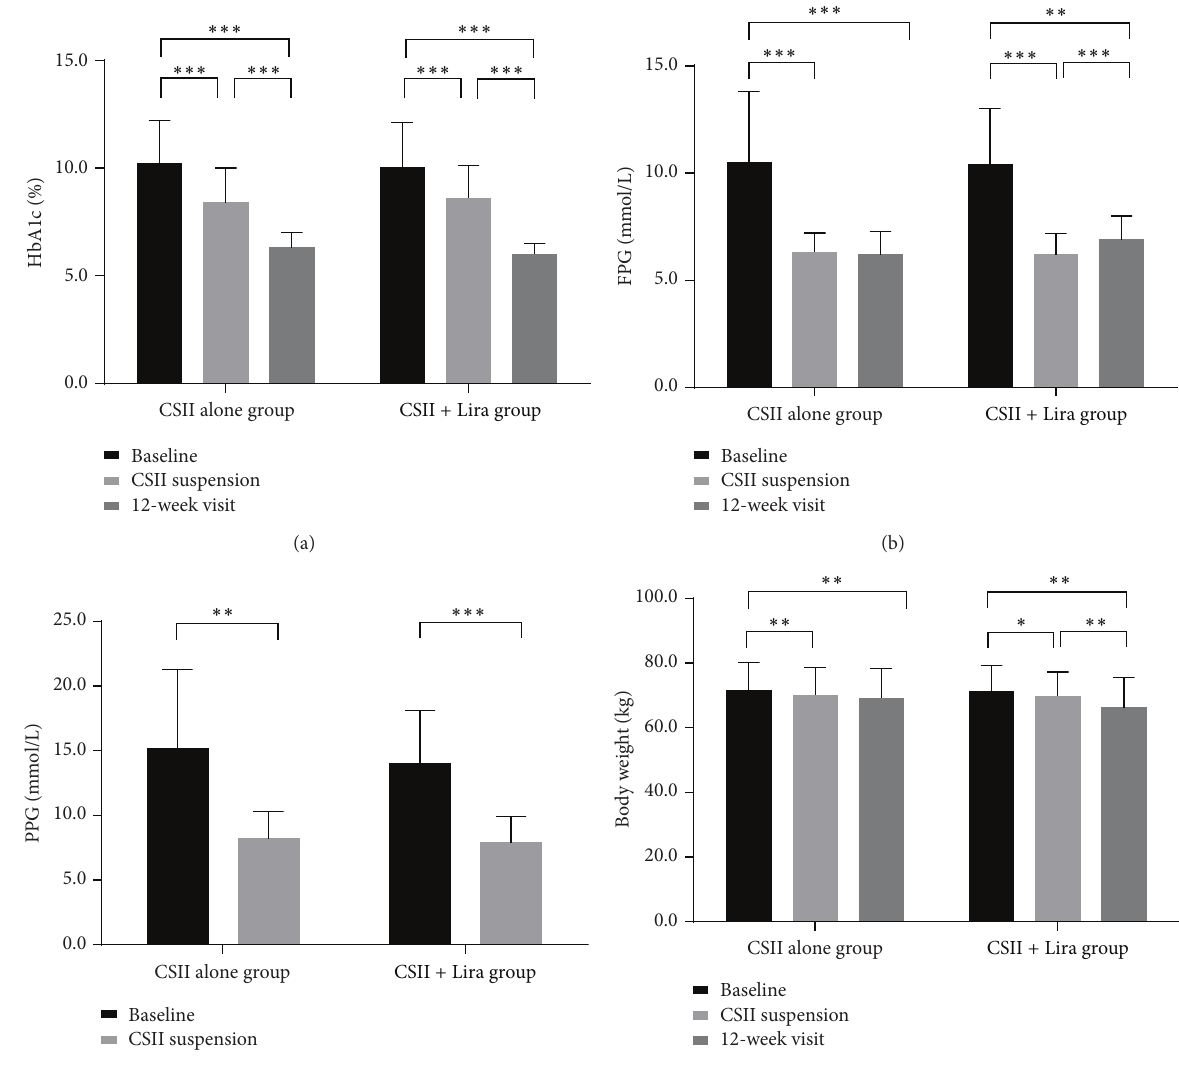
Figure 3: Glycemic control and body weight of two groups. (a) HbA1c of baseline and after interventions, (b) FPG of baseline and after interventions, (c) PPG of baseline and after CSII suspension, and (d) body weight of baseline and after intervention, ∗ 𝑃 < 0.05 , ∗∗ 𝑃 < 0.01 , and ∗∗∗ 𝑃 < 0.001